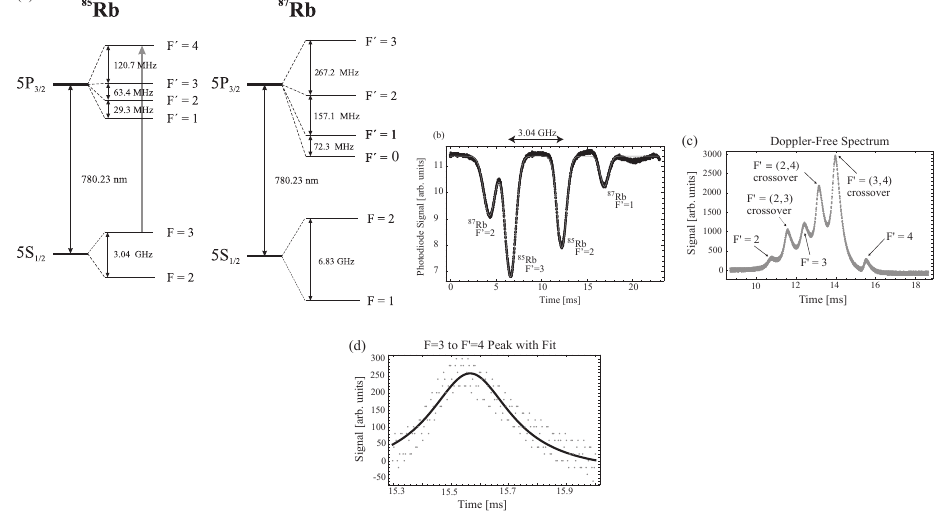
Figure 2. ( a ) Energy level diagrams for 85 Rb and 87 Rb. The Rb reference cell contains the two naturally occurring isotopes in the number ratio of 72:28. ( b ) Oscilloscope trace of Doppler broadened absorption spectra in 85 Rb and 87 Rb observed by scanning the external cavity diode laser (ECDL). The ground states corresponding to each peak are labeled. The frequency interval between the two ground states in 85 Rb is marked. The time axis can be converted to frequency units based on the known separation between energy levels. The full width at half maximum (FWHM) extracted from a Gaussian fit of the F = 3 → F (cid:48) = 2,3,4 resonance is 735 ± 5 MHz. Based on Beer’s law, I = I 0 e − α ( ν ) l where α ( ν ) is the absorption coefficient, l is the length of the Rb cell, I 0 is the incident intensity and I is the transmitted intensity. We find that the maximum absorption corresponds to an optical depth of α 0 l = 0.516 ± 0.003, where α 0 = α ( ν 0 ) and ν 0 is the resonance frequency. ( c ) Oscilloscope trace of Doppler-free spectrum for the 85 Rb F = 3 → F (cid:48) = 2,3,4 transitions. The frequency interval between the F (cid:48) = 4 peak and the adjacent crossover resonance is 60.4 MHz. ( d ) An expanded plot of the F = 3 → F (cid:48) = 4 resonance line. A FWHM of 12.7 ± 0.9 MHz is obtained from a Lorentzian fit. In general, this value should have contributions from the natural broadening ( ∼ 6 MHz), power broadening, and laser